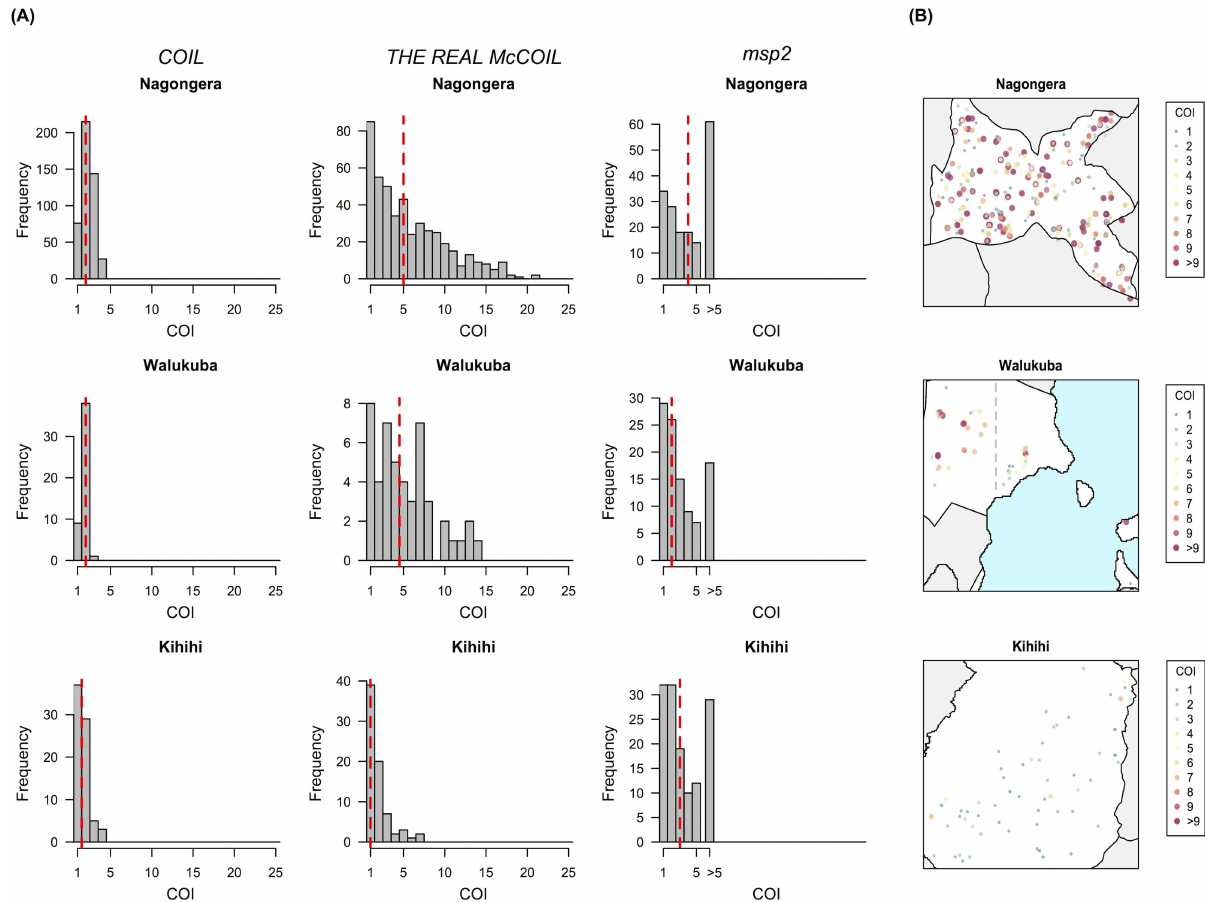
Fig 2. Estimatesof COI in Nagongera, Walukuba, and Kihihi. (A) Estimates of COI by COIL , THE REAL McCOIL , and msp2 . For THE REAL McCOIL , the point estimates of COI shown are mediansfrom the posterior distributions. The COI estimated by THE REAL McCOIL in Nagongeraand Walukubawere similar, and much higherthan that in Kihihi (median COI = 5 [Nagongera], 4.5 [Walukuba], and 1 [Kihihi]; permutationtest, p -values = 0.158 [Nagongera vs. Walukuba], 0.002 [Nagongera vs. Kihihi], 0.0006 [Walukubavs. Kihihi]). Allele counts > 5 in msp2 typing were groupedinto a single category due to difficulties in accuratelydistinguishing artifacts from true allelesat high complexitiesof infection. The dashed red lines represent the mediansof COI in three regions. (B) The spatialdistributionof estimated COI by THE REAL McCOIL in three regions. Small randomnoise was added to the location of samplesin the map. COI of samples collected from the West of Walukubawas higherthan those from the East of Walukuba(medians= 5 [West] and 3 [East], p -value=